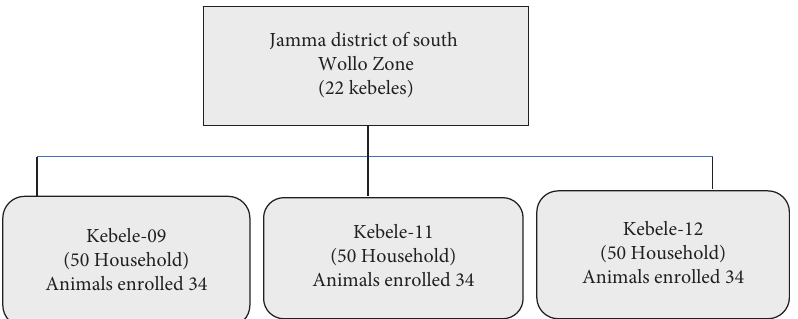
Figure 1: Graphic illustration of the sampling procedure for selecting study animals from Jamma district, South Wollo zone, Amhara Regional State, Ethiopia,